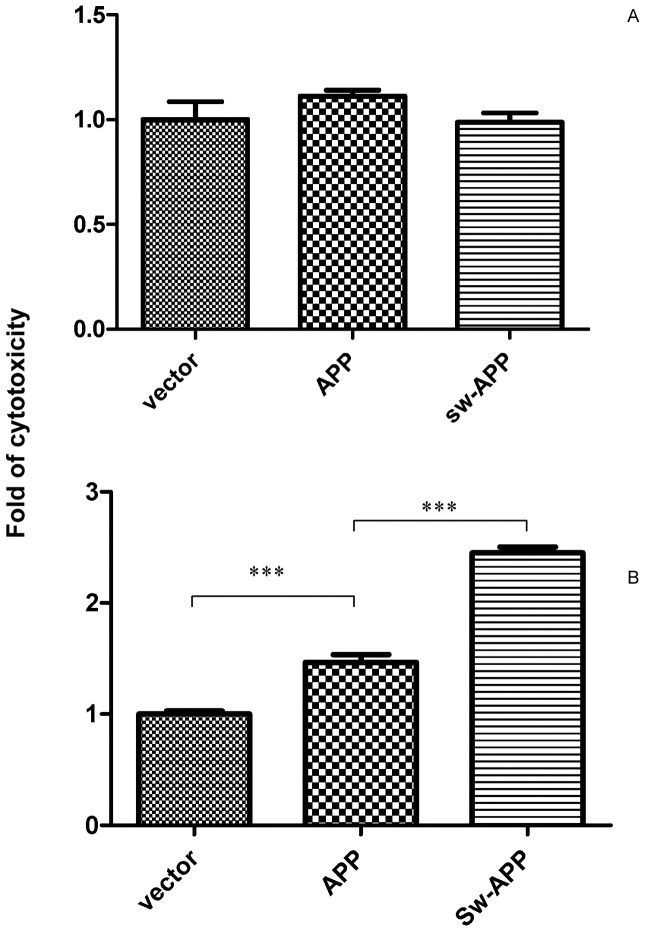
Cytotoxicity of SH-SY5Ycells transfected with empty vector, wild-type APP and the Swedish-APP mutant.
A. LDH assay revealed that the basal cytotoxicity of Sw-APP transfected (sw-APP), wt-APP transfected (APP) and empty-vector transfected (vector) SH-SY5Ycells are indifferent. B. Sw-APP transfected (Sw-APP) cells had increased cytotoxicity under oxidative stress induced by hydrogen peroxide (500 µM) than wt-APP transfected (APP) (p<0.0001) which had increased cytotoxicity under oxidative stress than empty-vector transfected (vector) cells (p<0.0001). Results shown were mean values from 3 independent cultures, and compared by one-way ANOVA using Newman-Keuls multiple comparison test.